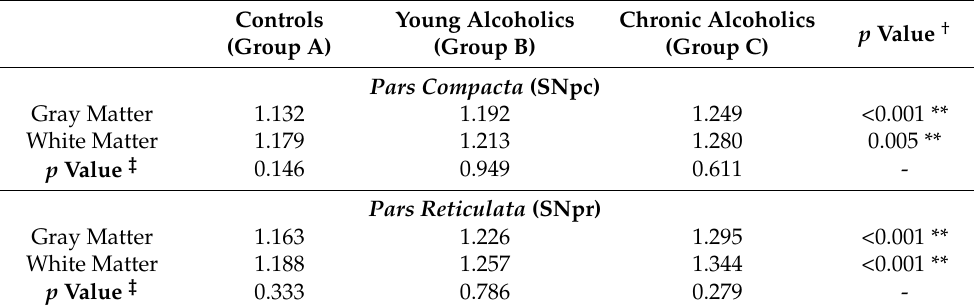
Table 5. Inter-group and intra-group comparisons of the differences in the grades of thickness of the BM based on the expression of laminin-111 in microvessels in the SN region (shown by weighted average).